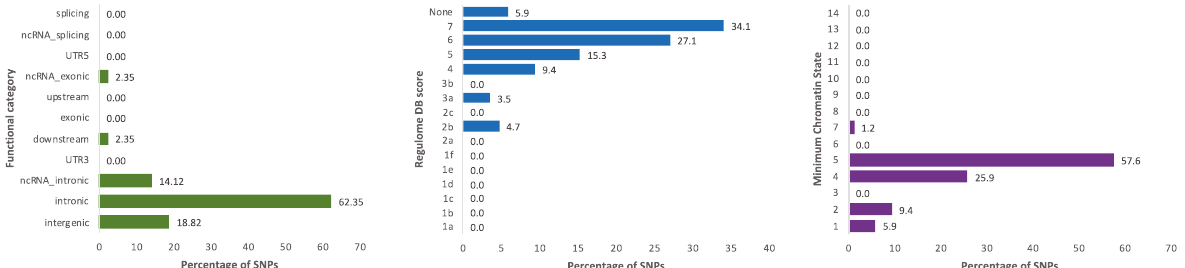
Fig. 2 Functional categories, Regulome DB scores, and minimum chromatin states for independent risk loci associated to any module eigengene. Regulome DB score predicts likelihood of regulatory functionality, lower scores indicate higher likelihood. Further information can be found in Boyle et al. [68]. Minimum Chromatin State across 127 tissue and cell types, lower scores indicate higher accessibility, with states 1 – 7 referring to open chromatin